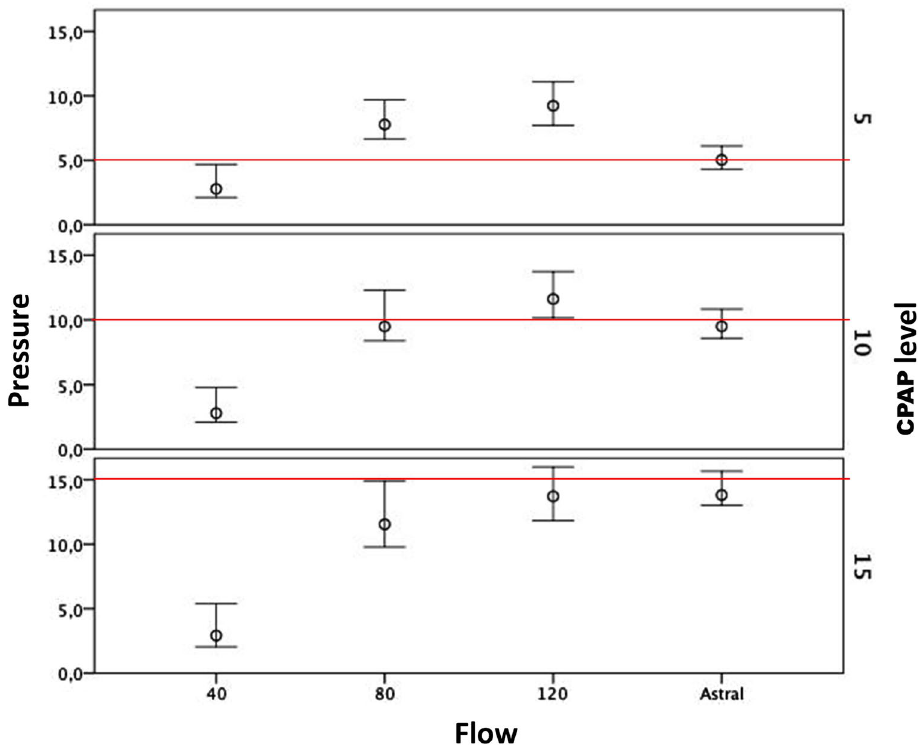
Figure 1. Pressure recorded inside the mask. Upper whiskers represent the average expiratory peak pressure at end-expiration. Lower whiskers represent the mean pressure at the average inspiratory peak pressure at end- inspiration; circles represent the mean pressure computed throughout the respiratory cycle; redline represents the set CPAP level.